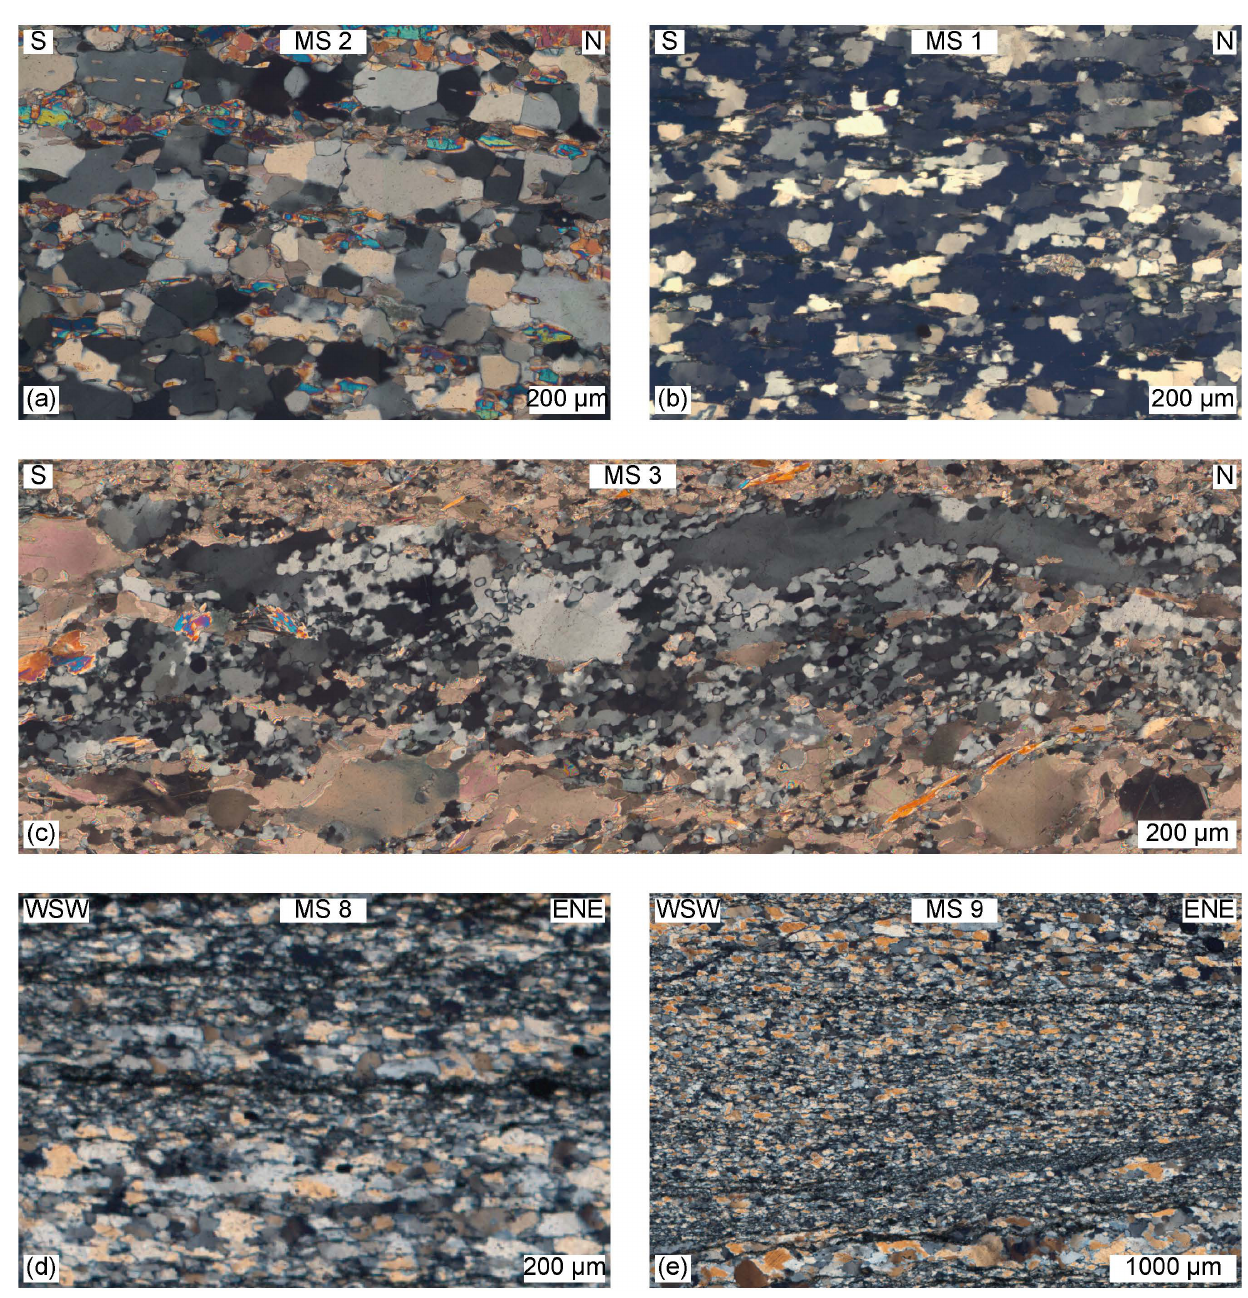
Figure 4. ( a ) Quartz microstructures affected by dynamic recrystallization. MS 2 shows large grains with lobate grain boundaries indicative of predominant GBM; ( b ) MS 1 shows brick-shaped grains with highly lobate boundaries (GBM), strong SPO due to SGR or pinning of quartz boundaries by a secondary phase; ( c ) Sample MS 3 with the highest calcite content is characterized by large leftover grains, presumably signs of an older deformation with predominant GBM, the dominant quartz recrystallization being due to BLG; ( d , e ) Microfabric of MS 8 and 9 resulting from thoroughgoing SGR, characterized by smaller grain size than ( a , b ) and brick-shaped grains with strong